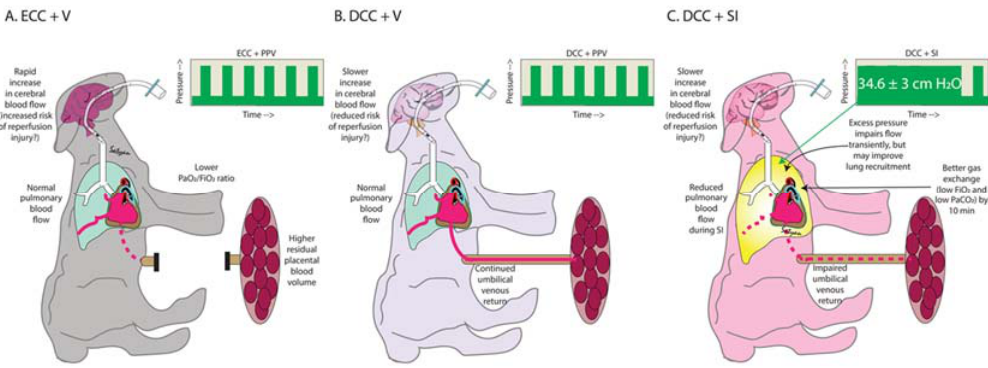
Figure 5. Summary: effects of ( A ) ECC + V—current practice, ( B ) DCC + V and ( C ) DCC + SI in our model of ovine asphyxia induced by cord occlusion.